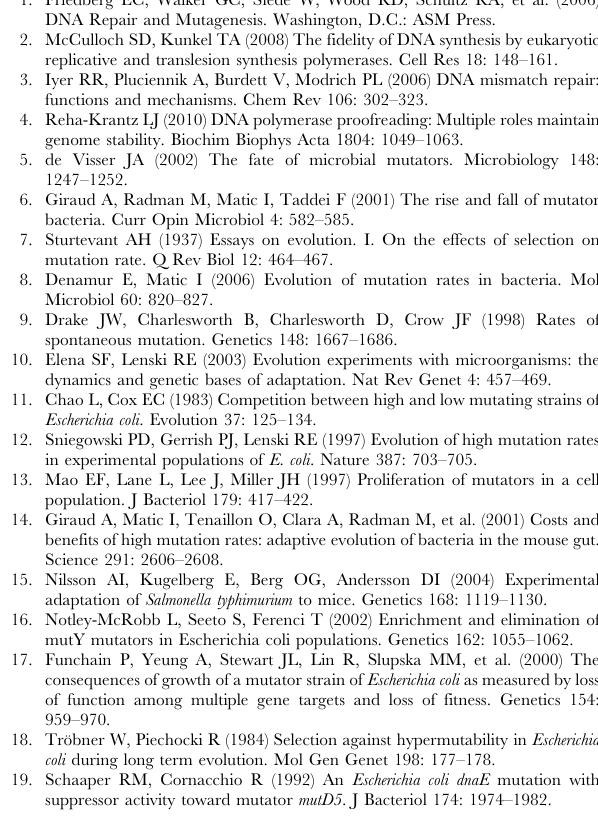
Table S4 Construction of chromosomal gene